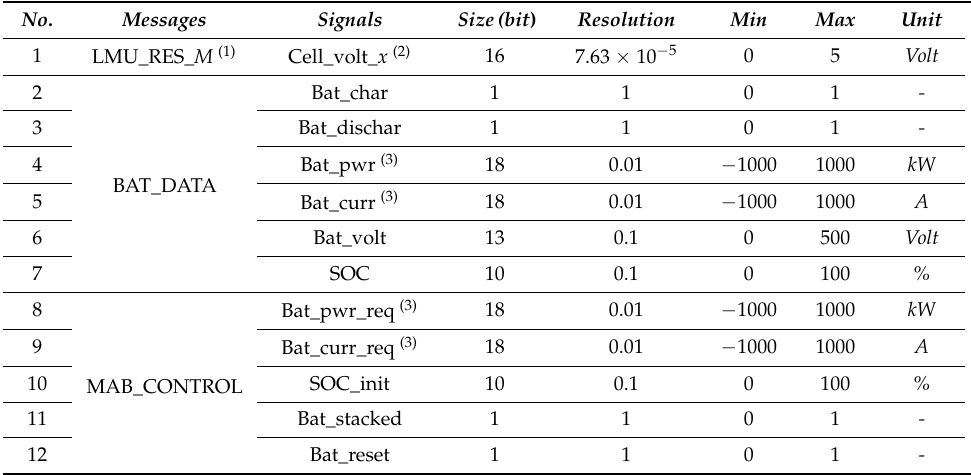
Table A1. Definition of CAN